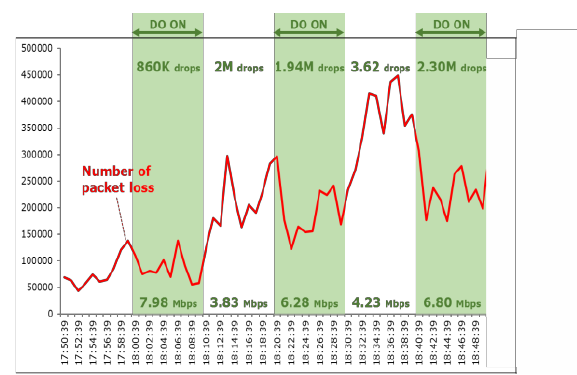
Figure 4. Packet loss observations in LTE